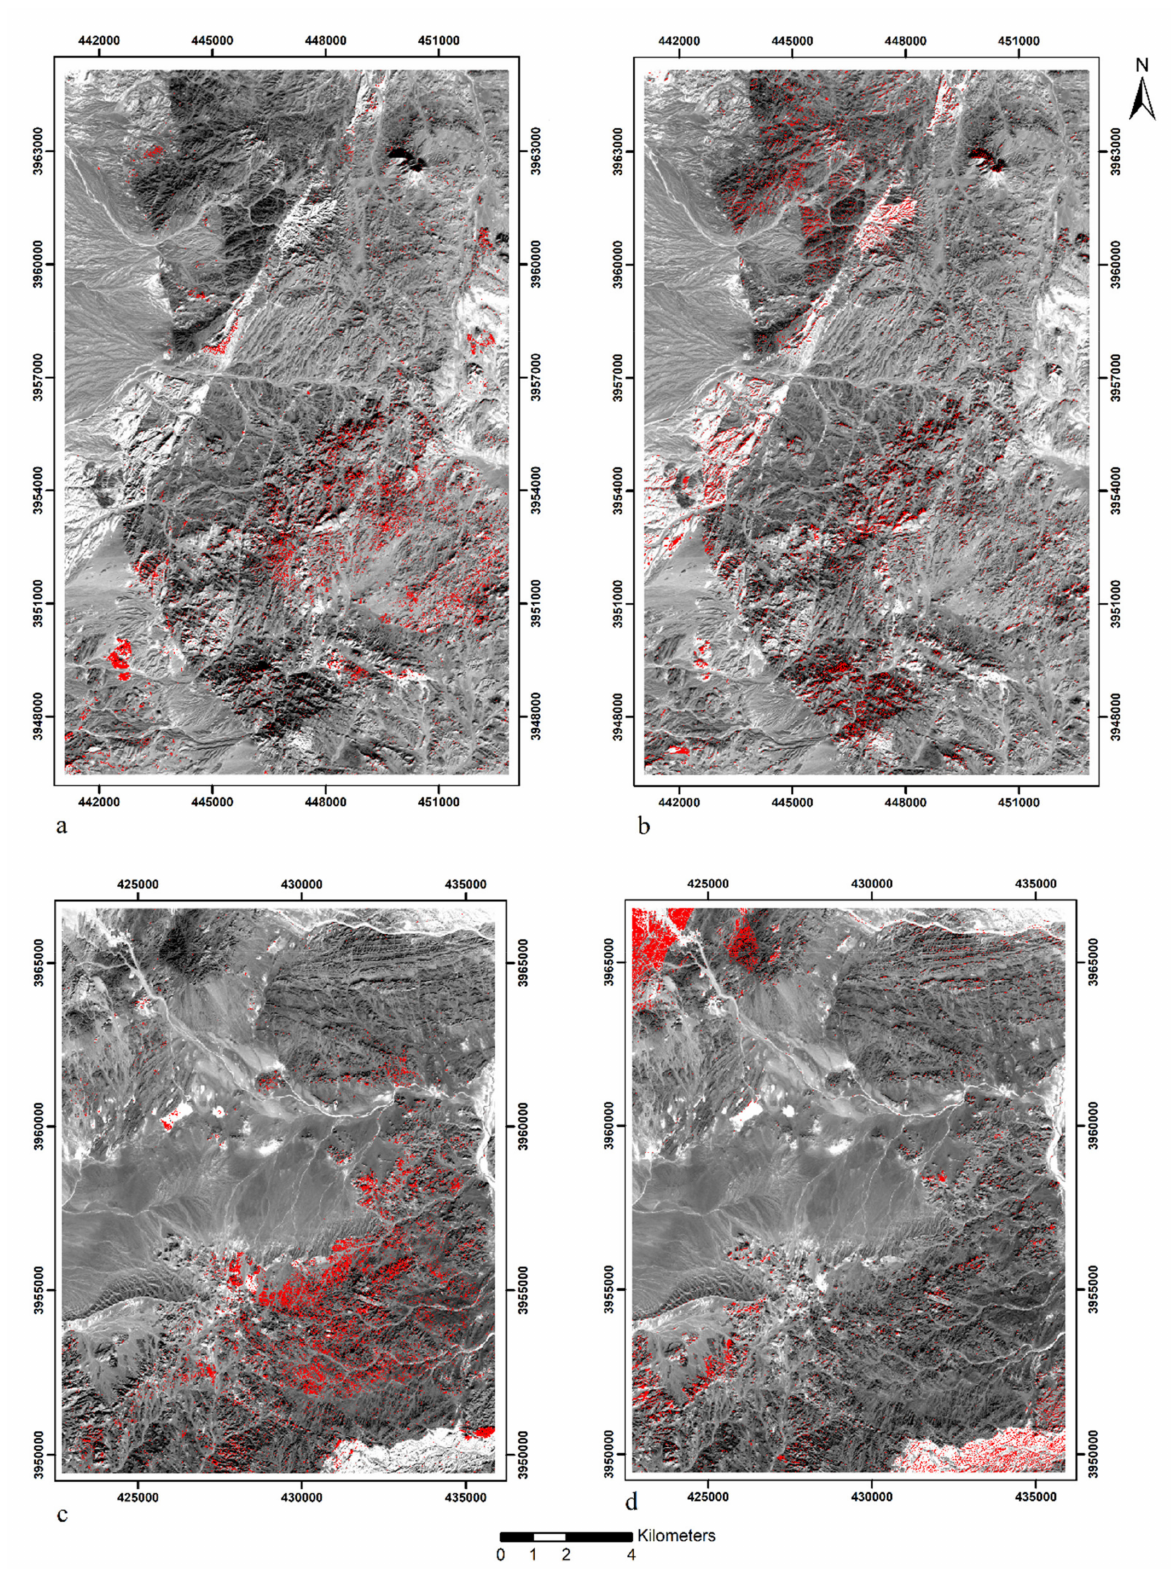
Figure 9. Band ratios of Sentinel-2 MSI image for identifying ferric iron (band 4/band 3): ( a ) zone I and ( c ) zone II; ferrous iron (band 12/band 8) + (band 3/band 4) in ( b ) zone I and ( d ) zone II on band